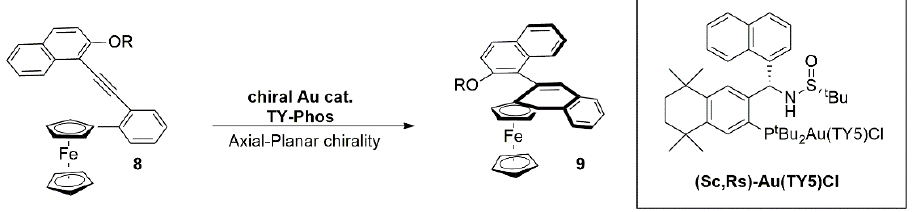
Figure 6 . Gold-catalyzed intramolecular quadruple hydroarylation to obtain aromatic aza[10]heli- cenes ( 11 ) with two pyridine units. In a later work (2018) by the same group, a similar catalytic system was used to achieve the enantioselective synthesis of fully benzenoid single and double carbo[6]heli- cenes [21]. In the same year the group of Alcarazo achieved the enantioselective synthesis of variously substituted carbo[6]helicenes ( 13 ) by exploiting the gold-catalyzed intramo- lecular hydroarylation reaction of suitable diynes ( 12 ) [22]. To this, a series of cationic phosphonites with a TADDOL skeleton as shared motif and different substituents at phos- phorus were produced and tested as chiral ancillary ligands (Figure 7). The study revealed that Au catalysts derived from triazoliumphosphonites are more active than the imidazo- lium-derivatives ones. The Au complexes obtained from phosphonites with 1,3-dimesityl- 1,2,3-triazolium and 1,4-dimesityl-1,2,4-triazolium substituents are the best precatalysts for the desired cyclization considering regio- and enantioselectivity.